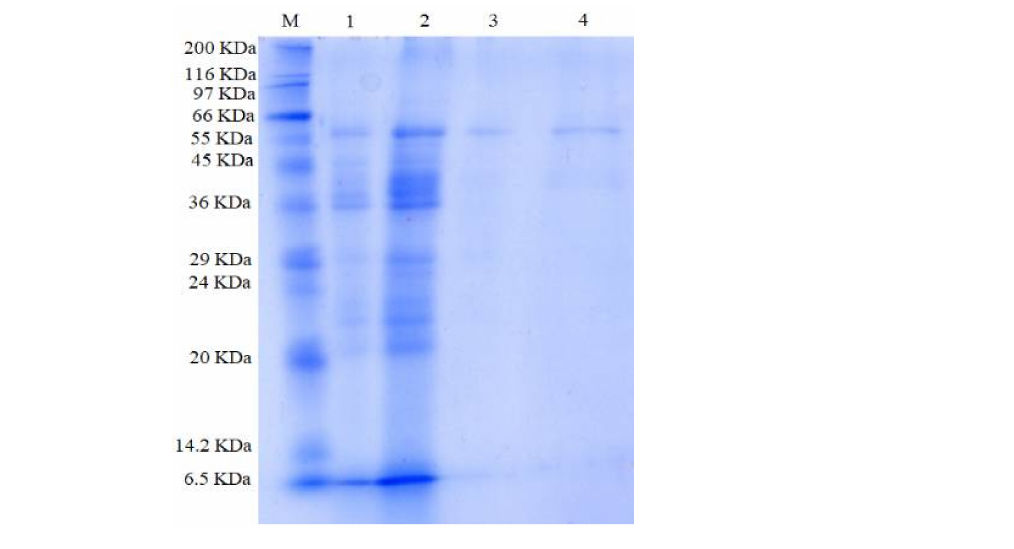
Figure 3. SDS-PAGE profiles of B. amyloliquefaciens TKU050 pectinase: (1) culture supernatant; (2) crude enzyme after (NH 4 ) 2 SO 4 precipitation; (3) pectinase fraction after running FPLC with a Macro-prep High Q column; (4) purified pectinase after running HPLC with a KW802.5 column. M represents the protein markers. Table 3. Comparison of pectinase produced by Bacillus